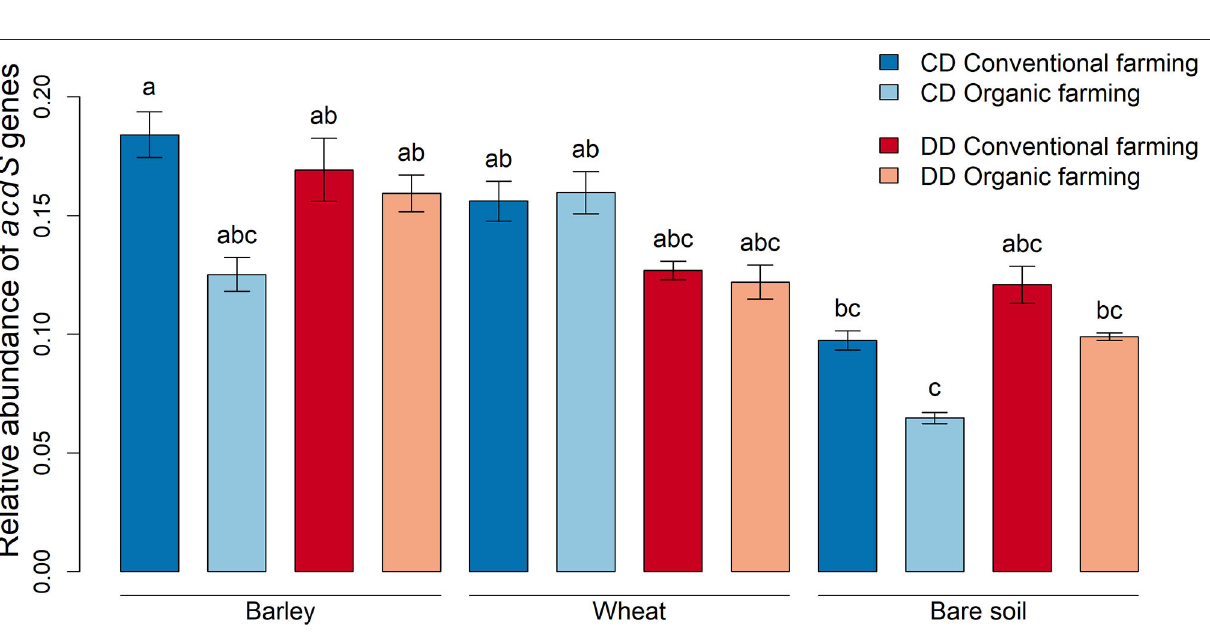
FIGURE 3 | Relative abundances of microorganisms with genes encoding for ACC deaminase. Abundance data obtained by qPCR were normalized with 16S rRNA gene abundances and calculated using the 1 Ct method (Livak and Schmittgen, 2001). Values correspond to the average, and error bars to the respective standard error, with five pot, replicates. Letters show the statistical differences between all treatments according to ANOVA followed by Tukey’s HSD post-hoc test. CD: “single water deficit,” control and dry conditions, DD: “water deficit history,” dry conditions and dry